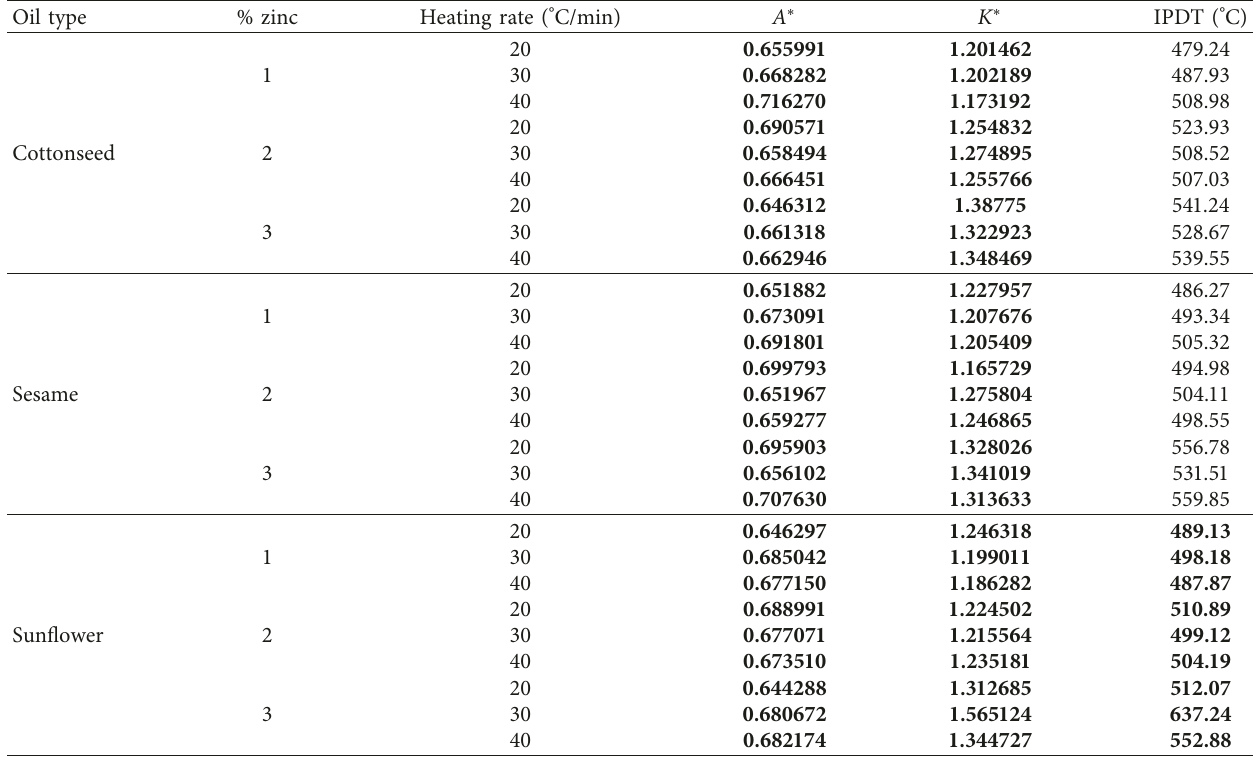
Table 4: A ∗ , K ∗ , and IPDT values of millet flour-based epoxy